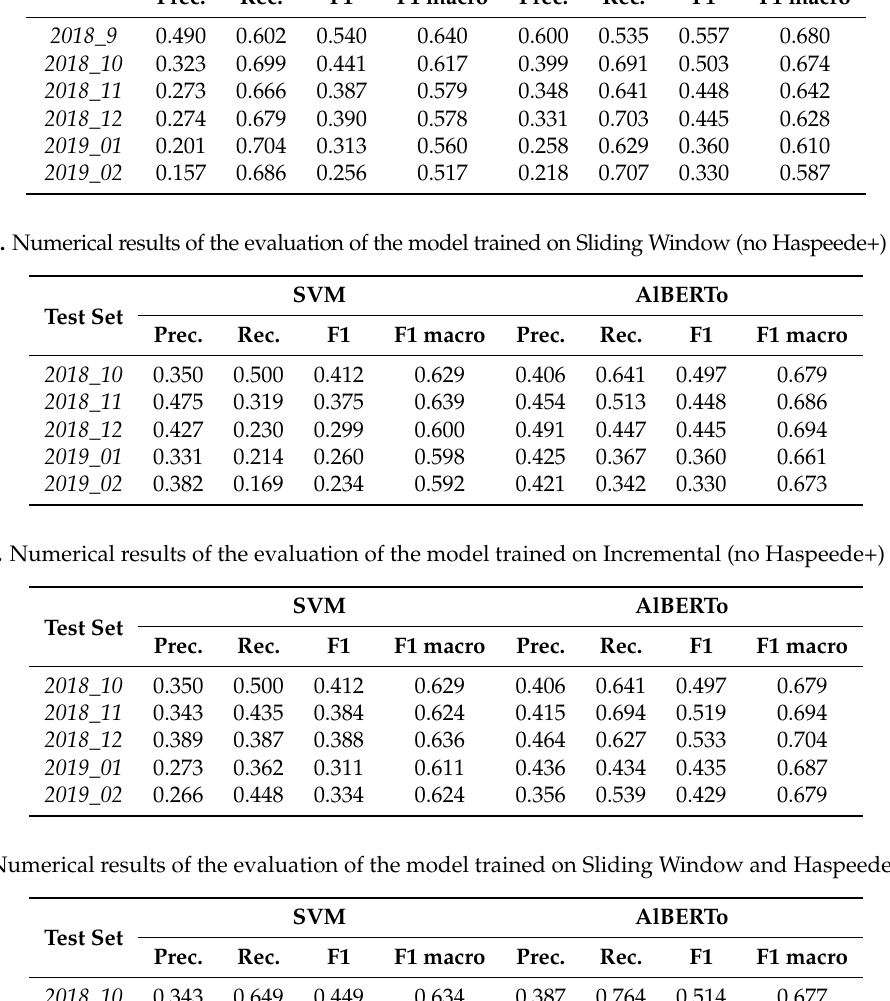
Table 3. Numerical results of the evaluation of the model trained on Haspeede+ (fixed training set). SVM AlBERTo Test Set Prec. Rec. F1 F1 macro Prec. Rec. F1 F1 macro